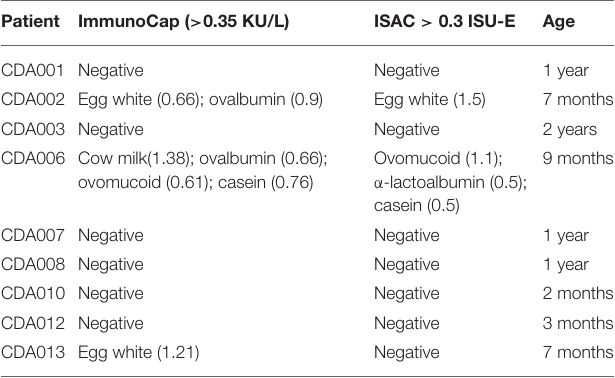
TABLE 2 | sIgEs determined by ImmunoCAP FEIA and ISAC in healthy control children. Patient ImmunoCap ( > 0.35